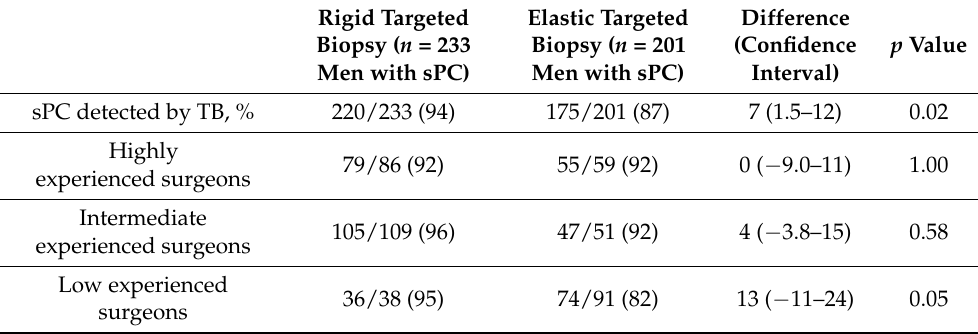
Table 2. Detection of significant prostate cancer by targeted fusion-biopsy and rigid vs. elastic registration and subanalyses of different surgical experience groups. sPC = significant prostate cancer.